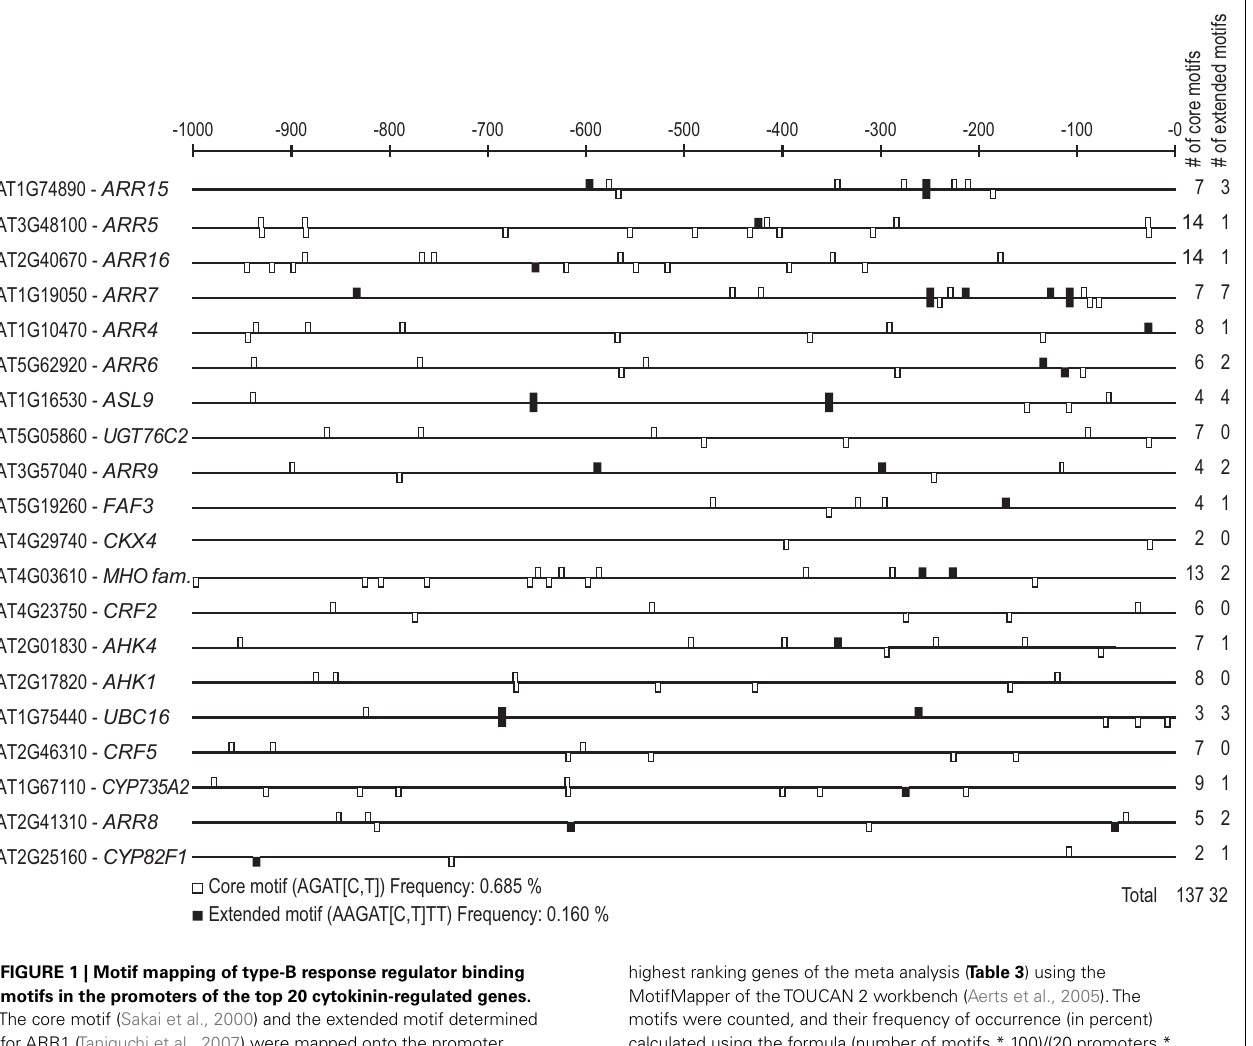
FIGURE 1 | Motif mapping of type-B response regulator binding motifs in the promoters of the top 20 cytokinin-regulated genes. The core motif (Sakai et al., 2000) and the extended motif determined for ARR1 (Taniguchi et al., 2007) were mapped onto the promoter regions 1000bp upstream of the translational start sites of the 20